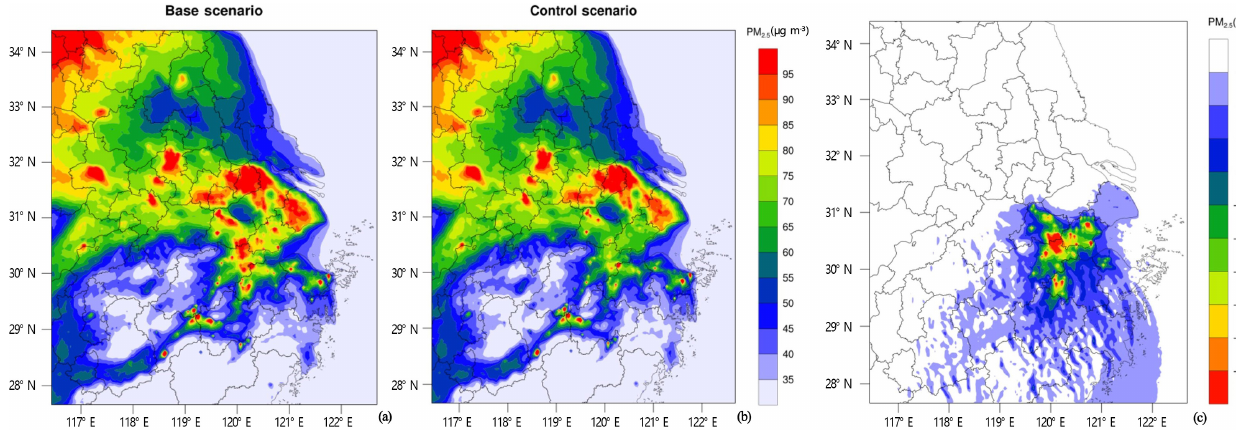
Figure 15. Spatial distribution of PM 2 . 5 concentrations in the Yangtze River Delta region under the baseline scenario (a) and the campaign scenario (b) , and the percentage reduction in PM 2 . 5 throughout the YRD region (c)